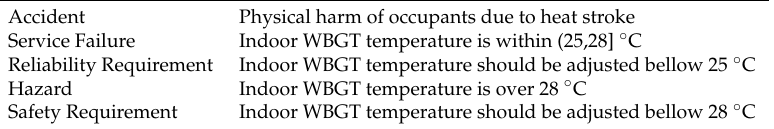
Table 3. Preparation for the tailored System-Theoretic Process Analysis (STPA).